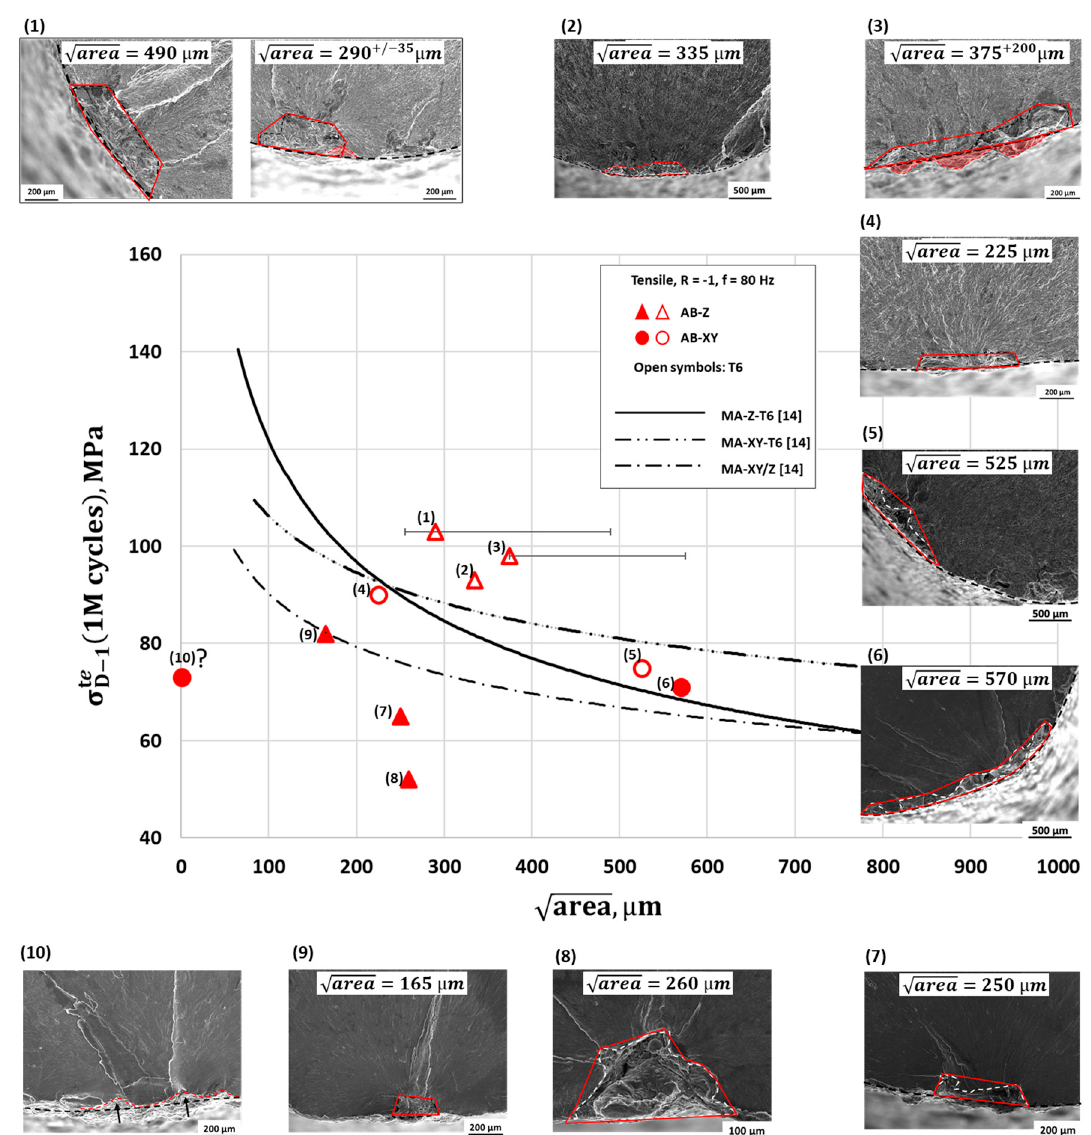
Figure 10. Kitagawa-type diagram showing the impact of defect size of the fatigue limit for as-built material and two building directions, XY and Z, in comparison with machined [14].